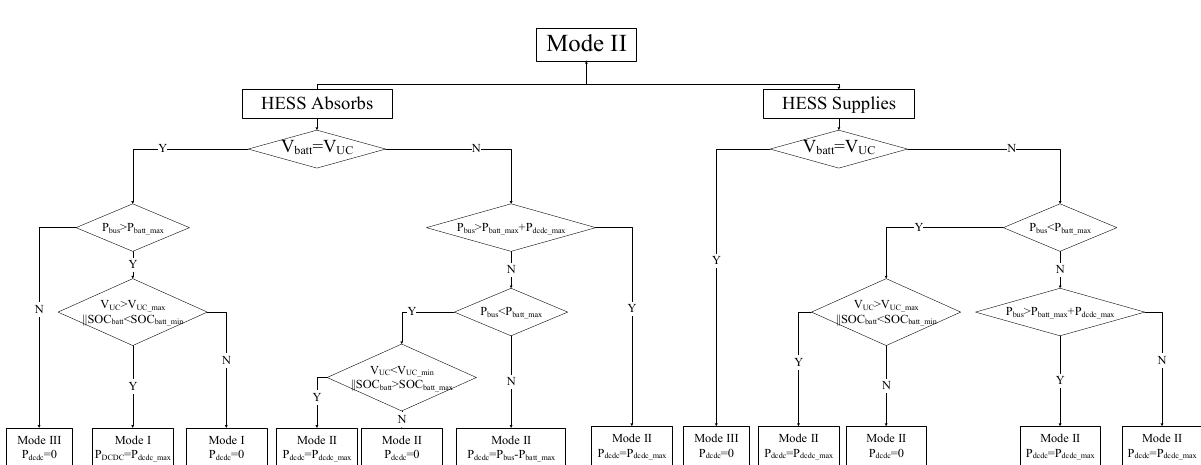
Figure 9. Control flowchart for Mode